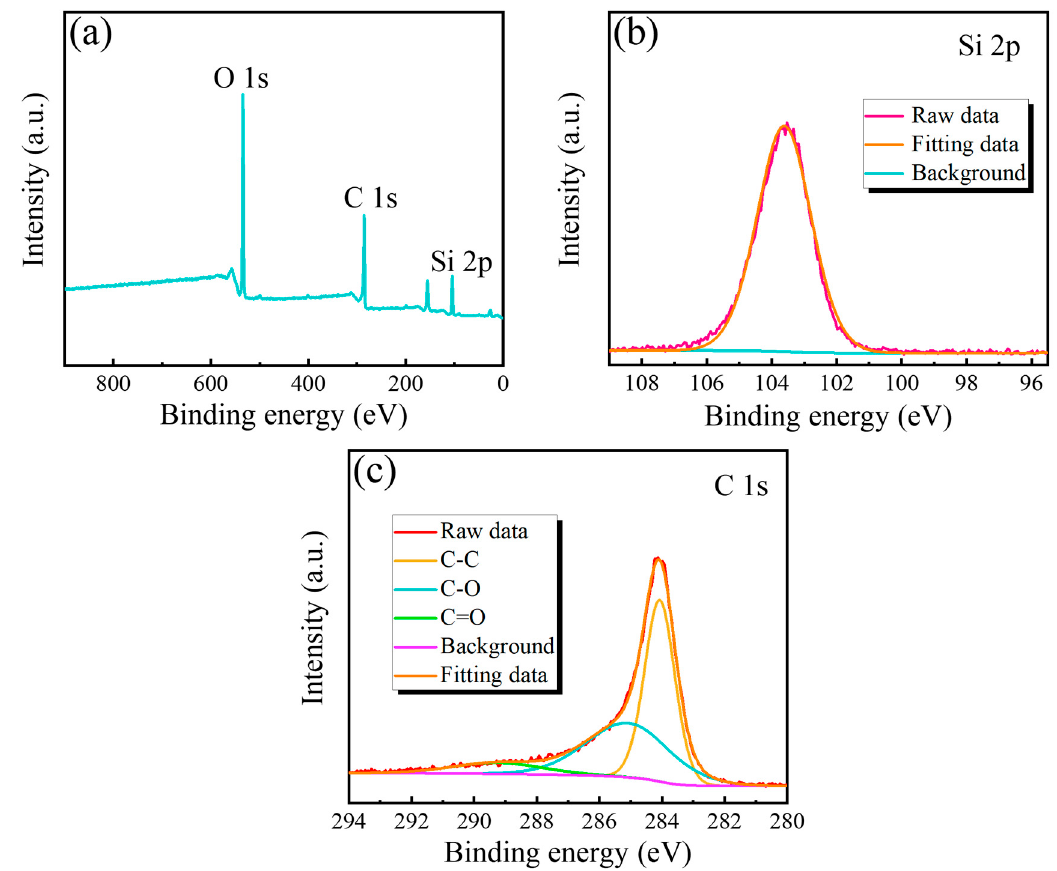
Figure 4. SiO 2 @C − 3: ( a ) XPS full spectrum, ( b ) Si 2p spectrum, ( c ) C 1s